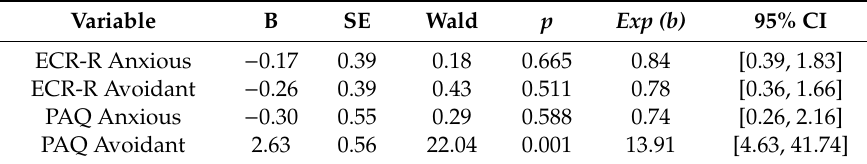
Table 6. Results of Binary Logistic Regression predicting SED carer Group Membership.